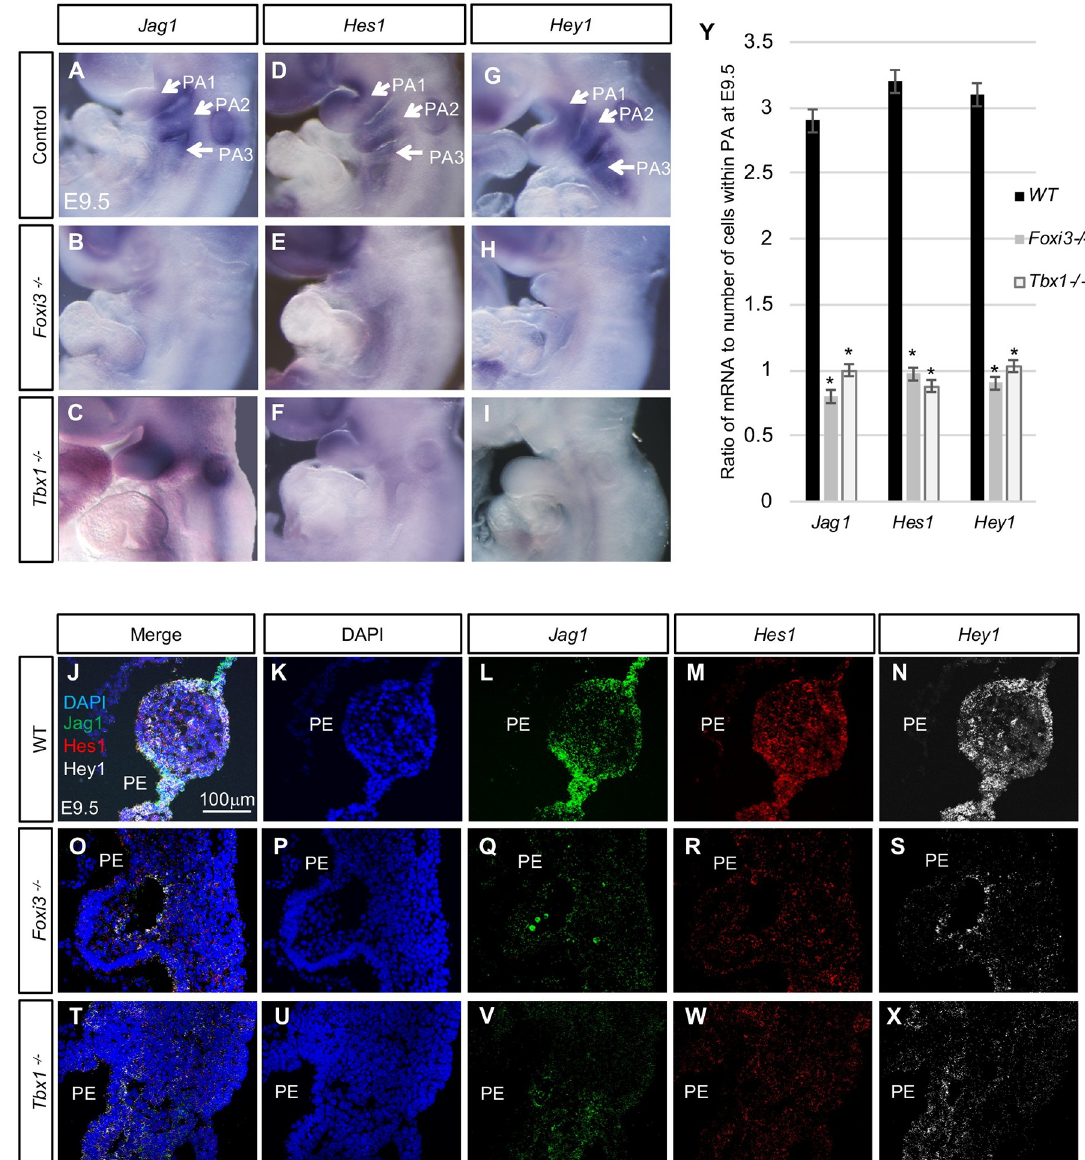
Fig 7. Expression of Notch pathway genes Jag1 , Hes1 , and Hey1 were downregulated in Foxi3 and Tbx1 null mutant embryos. (A-I) WMISH with antisense Jag1 , Hes1 , and Hey1 mRNA probes on whole mount embryos at E9.5. Jag1 antisense probe on WT (A), Foxi3 -/- (B) and Tbx1 -/- mutant embryos (C); n = 3 of each genotype. Hes1 probe on WT (D), Foxi3 -/- (E) and Tbx1 -/- (F) mutant embryos; n = 2–3 for each genotype. Hey1 probe on WT (G), Foxi3 -/- (H) and Tbx1 -/- (I) mutant embryos; n = 2, each. (J-X) RNAscope in situ hybridization with mRNA probes for Jag1 , Hes1 , and Hey1 on coronal sections of WT (J-N), Foxi3 -/- (O-S), and Tbx1 -/- (T-X) embryos at E9.5; n = 3, each genotype. Merged channels are shown (J, O, and T); DAPI is shown in blue color (K, P, and U); Jag1 mRNA expression is in green (L, Q, and V); Hes1 mRNA expression is in red (M, R, and W); and Hey1 expression is in white (N, S and X). The sections correspond to the same rostral-caudal location within in each embryo. (Y) Quantification of RNAscope experiments on WT versus Tbx1 -/- and Foxi3 -/- embryos at E9.5. Nuclei and mRNA were quantified for each section and probe. The total number of mRNA signal dots was divided by the total number of cells for each replicate. Graph represents the average ratio. Asterisks indicate P- values <